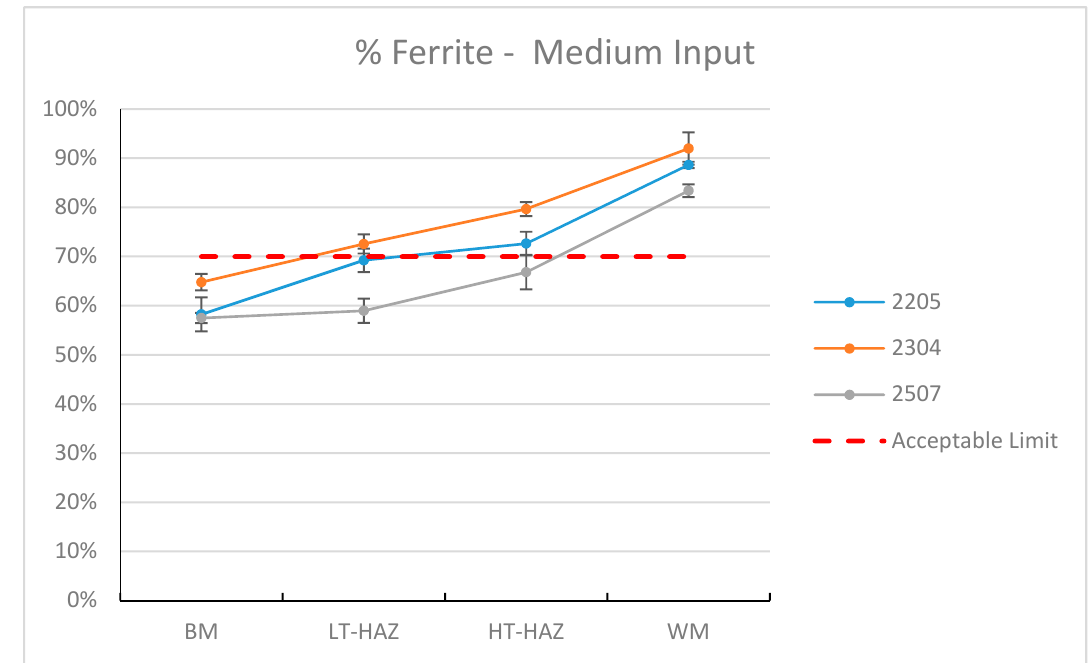
Figure 10. Volumetric Fraction of ferrite—Medium Input: BM; LT-HAZ; HT-HAZ; WM.